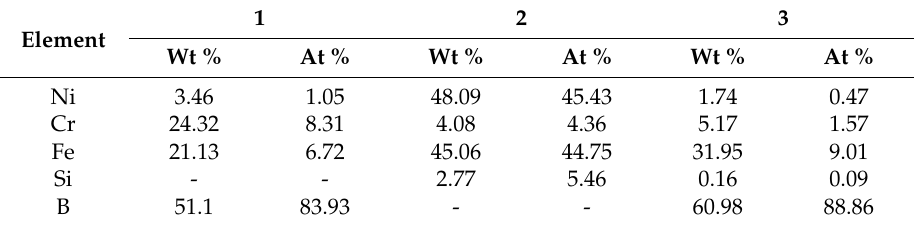
Table 2. The chemical compositions labeled 1,2,3 in Figure